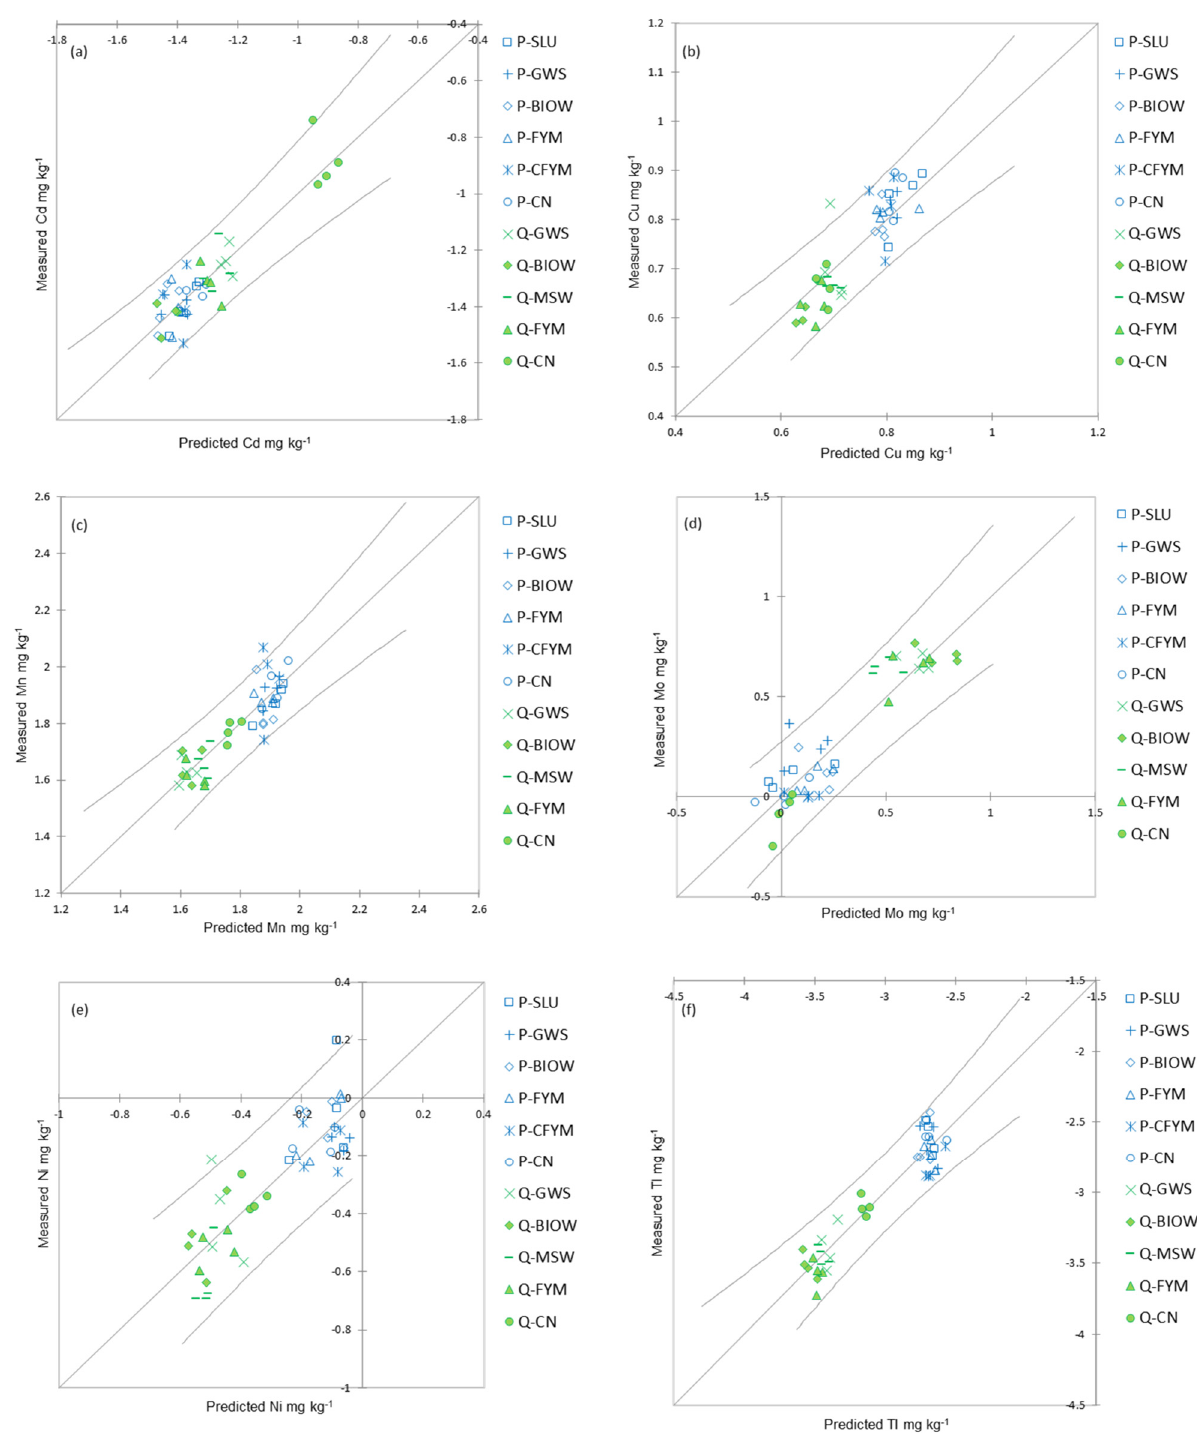
Figure 5. Multiple log–log linear regression studies for trace elements measured in plantlets at both sites, for Cd ( a ), Cu ( b ), Mn ( c ), Mo ( d ), Ni ( e ) and Tl ( f ), with the following data presented: Number of values = 44, with lower and upper bounds (95%). See Figures 1 and 2 for treatments signification.